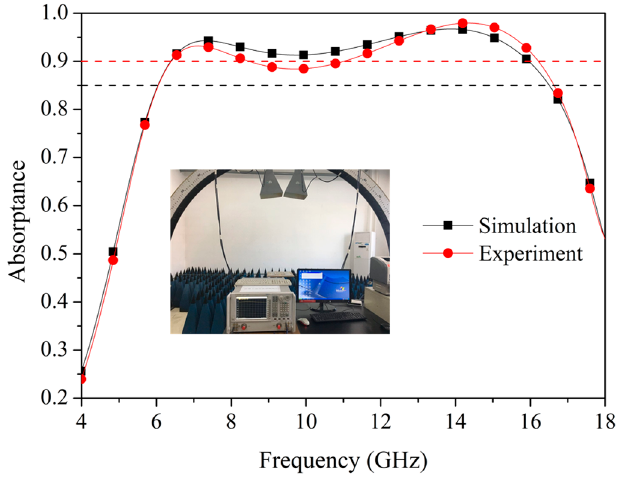
Figure 10. Comparison of measured and simulated absorptance of the absorber.